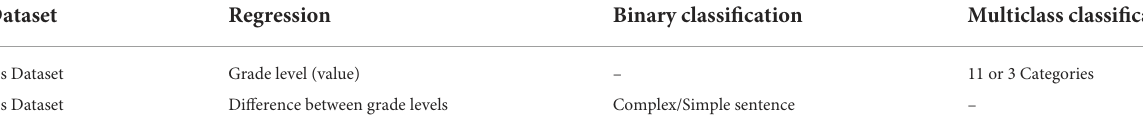
TABLE 4 Setup of five tasks used for model evaluation in the study: two regression tasks, one binary classification, and two multiclass classification tasks.